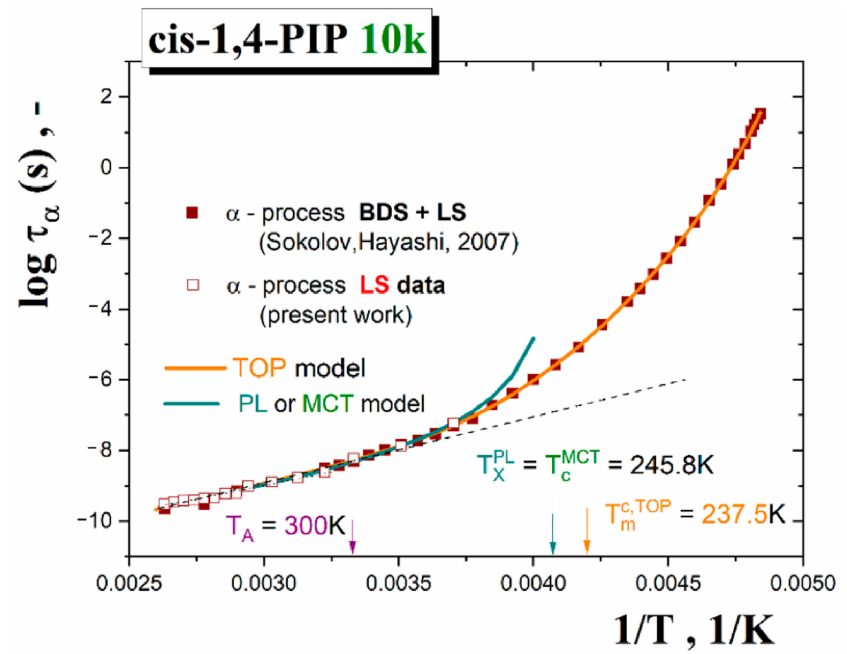
Figure 7. Arrhenius plot of the segmental α relaxation time, τ α , for cis -1,4-PIP10k as obtained from the present Light Scattering LS work together with those from a combined BDS and LS study of the same cis -1,4-PIP10k in Ref. [50]. Fit curves of the Power Law (PL) function or the Mode Coupling theory (MCT) model (Equation (10)) over intermediate- and high- T region as well as the TOP model (Equation (11)) over the whole T range are included and commented in the text in